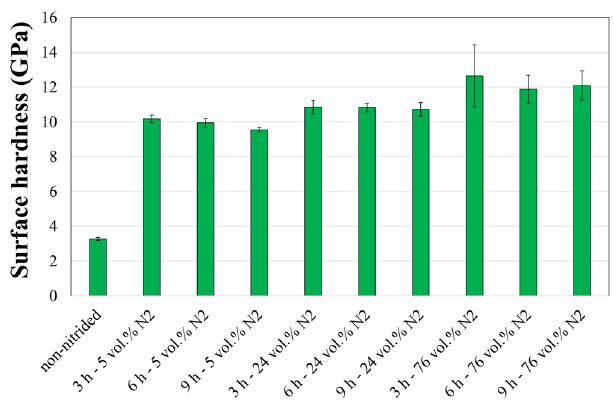
Figure 5. Surface hardness of non-nitrided and plasma nitrided samples.